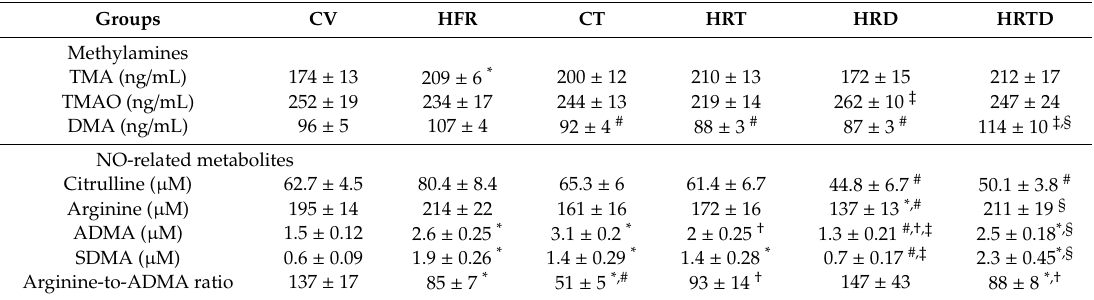
Table 2. Plasma levels of methylamines and NO-related metabolites at 12 weeks of